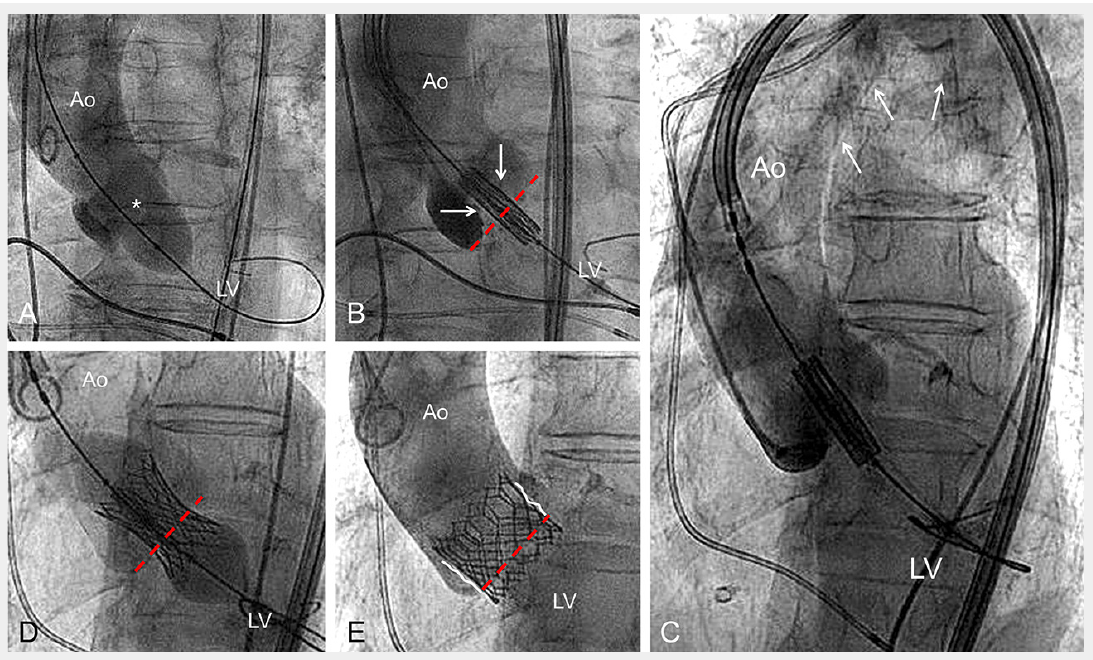
Example of the different procedural steps of a standard TAVI intervention using a balloon-expandable valve. Procedural steps of a standard TAVI using a balloon-expandable transcatheter heart valve. A: aortic valve valvuloplasty (*) in order to facilitate valve crossing with the delivery system; B: positioning of the loaded bioprosthesis into the aortic annulus (red interrupted line). The arrows indicate the semi-opened valve leaflets C: overview of the delivery catheter introduced via the right femoral artery and crossing the aortic arch (arrows). D: implantation of the valve through progressive balloon inflation (the aortic annulus plane is represented by the interrupted red line); E: final contrast medium injection after removal of the delivery catheter excluding relevant aortic regurgitation. Schematic representation of the native valve leaflets (white lines) maintained opened by the valve stent. Ao = aorta; LV = left